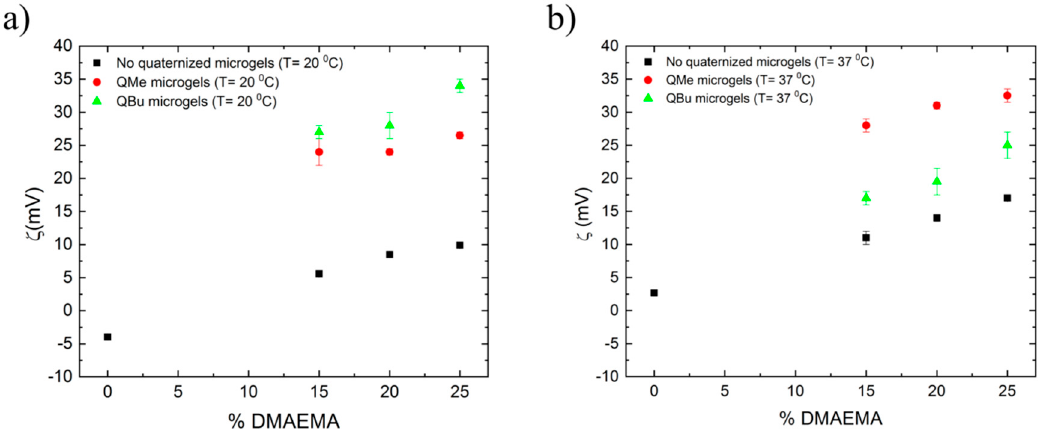
Figure 6. Evolution of zeta potential with DMAEMA content for unquaternized and quaternized microgel samples with ( a ) methyl iodide (QMe) and ( b ) butyl iodide (QBu) alkyl agents, respectively.